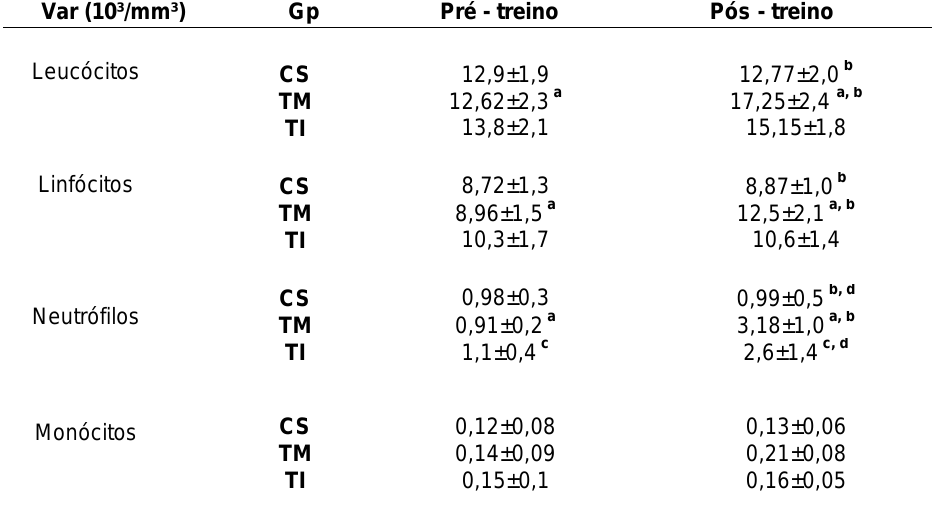
Tabela 1. Análise da contagem total e diferencial de leucócitos do sangue periférico de ratos adultos intra e entre os grupos antes e após o treino de 6 semanas.